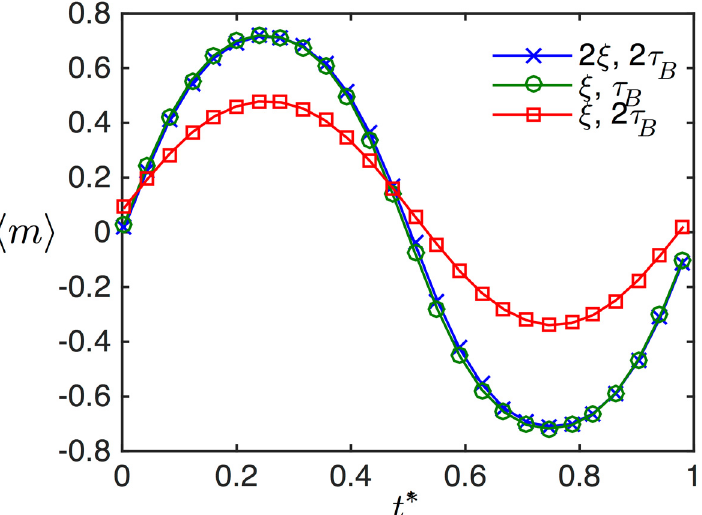
Fig 1. (Color online) The scaling relationship between the magnetic field and relaxation time is demonstrated by simulating the mean magnetization response of a polydisperse ensemble of magnetic nanoparticles in an oscillating applied magnetic field. The normalized mean magnetization is identical if the field and the relaxation time are multiplied by the same number.